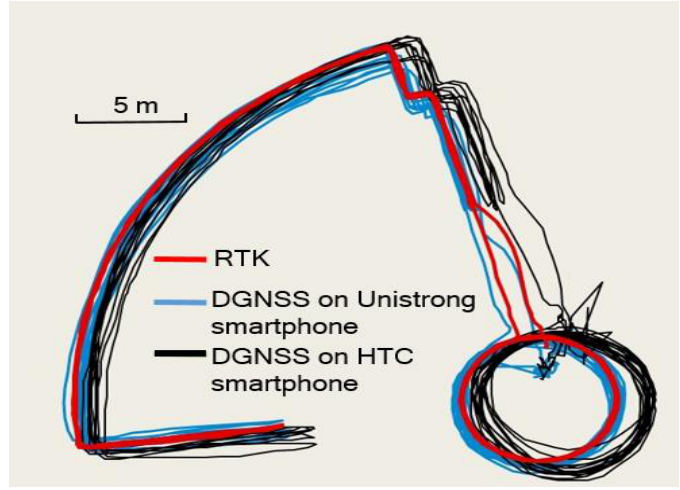
Figure 6. Performance comparison between two smartphones.